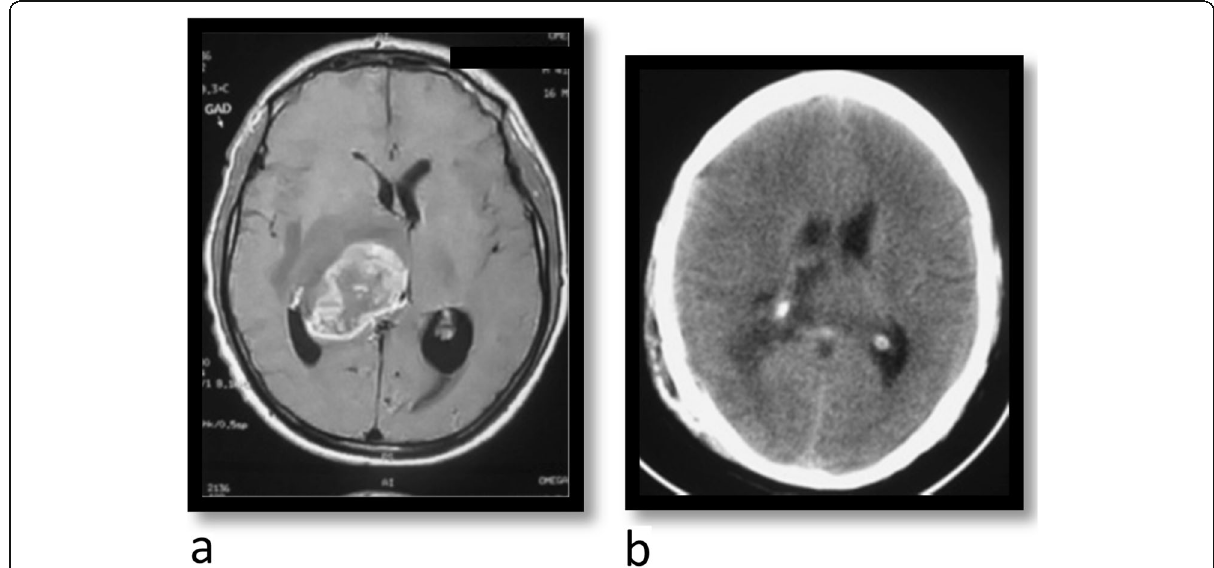
Fig. 8 a On the left axial T1 contrast for posterior thalamic glioma and b on the right follow up CT showing removal through parietal transcortical